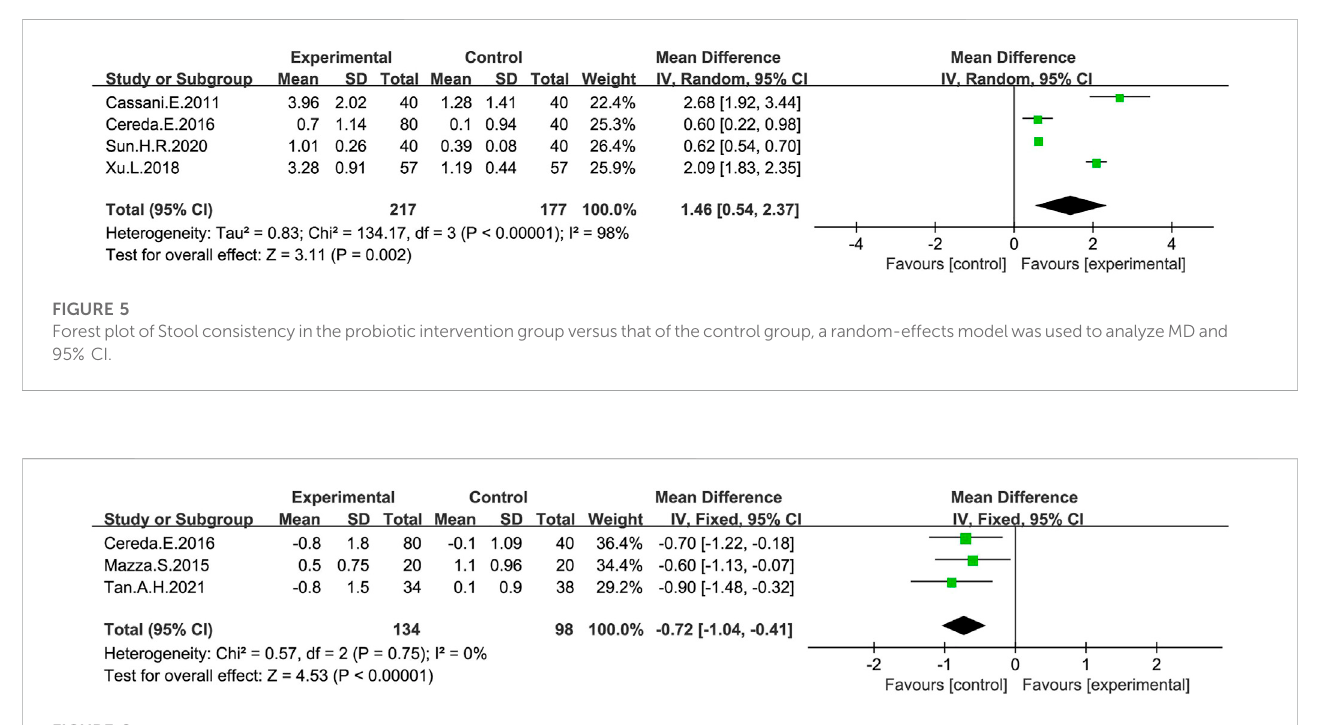
FIGURE 6 Forest plot of the Number of laxatives used in the probiotic intervention group versus that of the control group, with MD and a 95% CI analysis using a random-effects model.